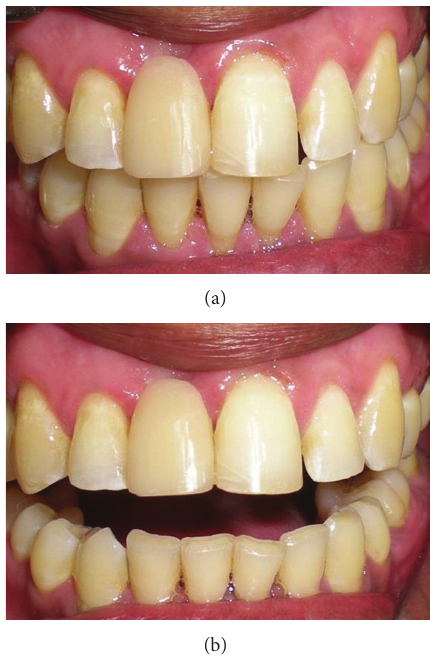
Figure 6: (a) and (b) Facial view of definitive prosthesis.